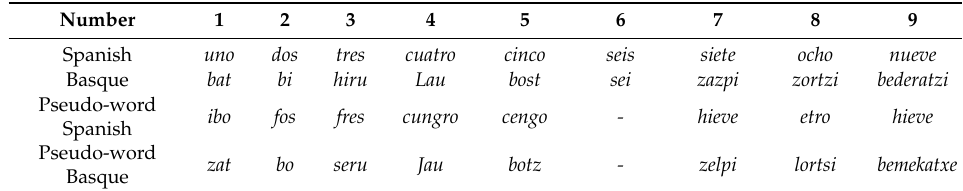
Table 2. Written forms of the numbers in Spanish, Basque and the pseudo-words created for each language. Their corresponding digits are also presented. Numbers six was excluded from the study due to its similarity in Basque and Spanish and nine was excluded from the analyses due to the fact that its di ff erence in length with the rest of the numbers helped to recognize it faster.